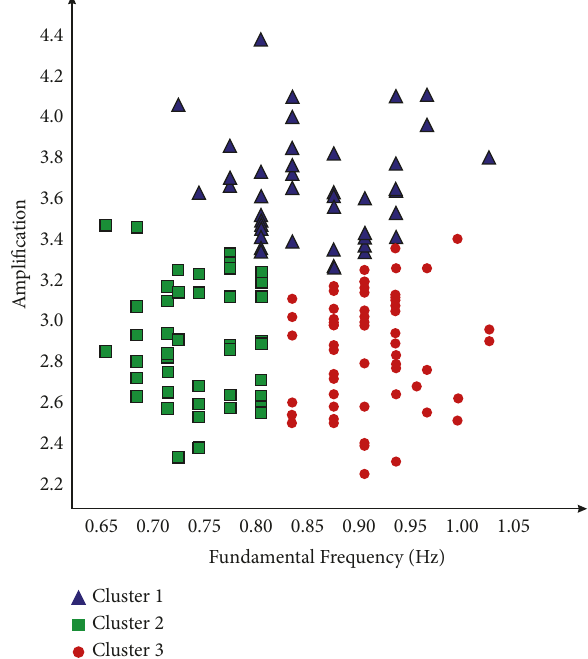
Figure 8: Scatter plot of frequency and amplitude by fuzzy C-mean clustering